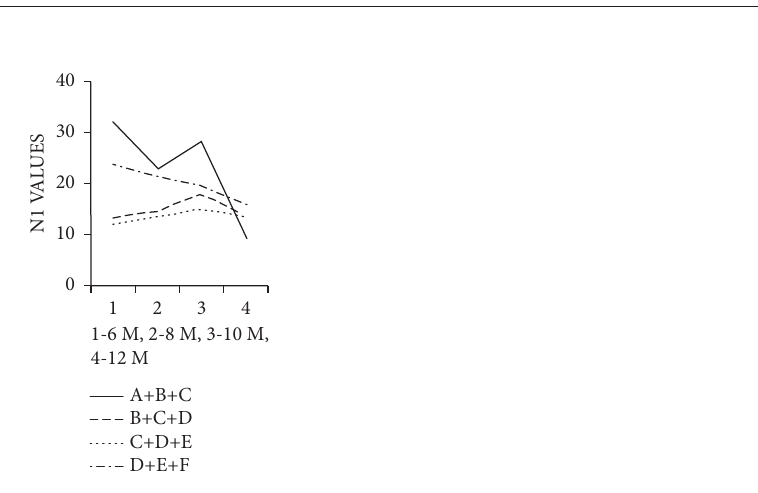
Figure 8: N1 values with increasing molarity (28 days’ curing) combinations from A to